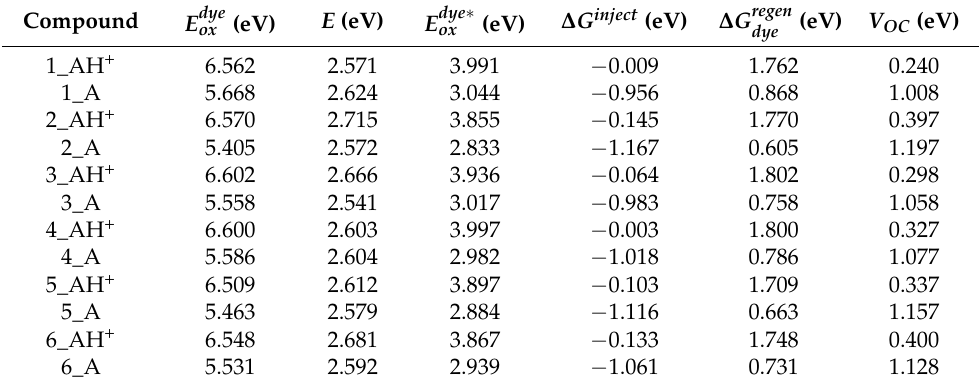
Table 3. Photovoltaic parameters computed at B3LYP/6-31+G (d, p) level of theory.